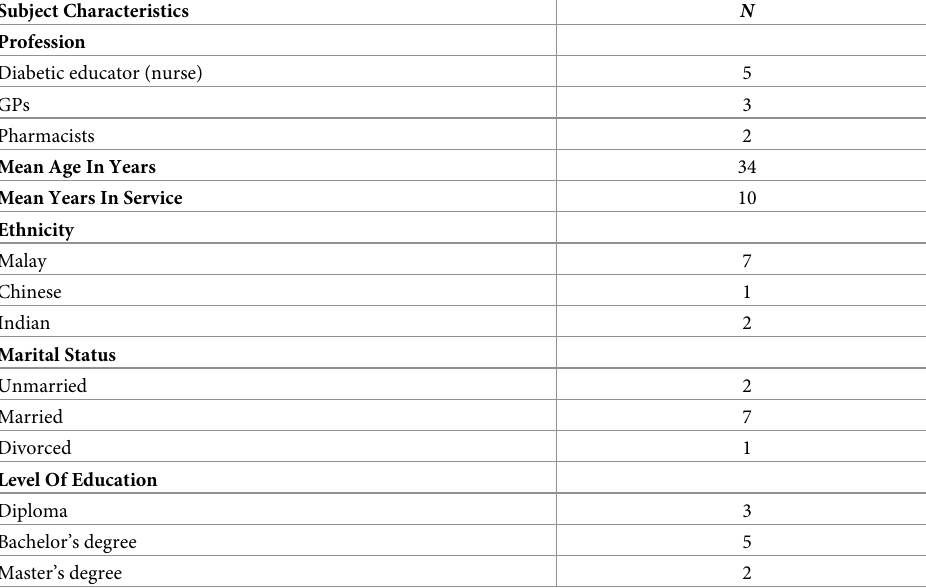
Table 2. Demographic details of health care workers of the